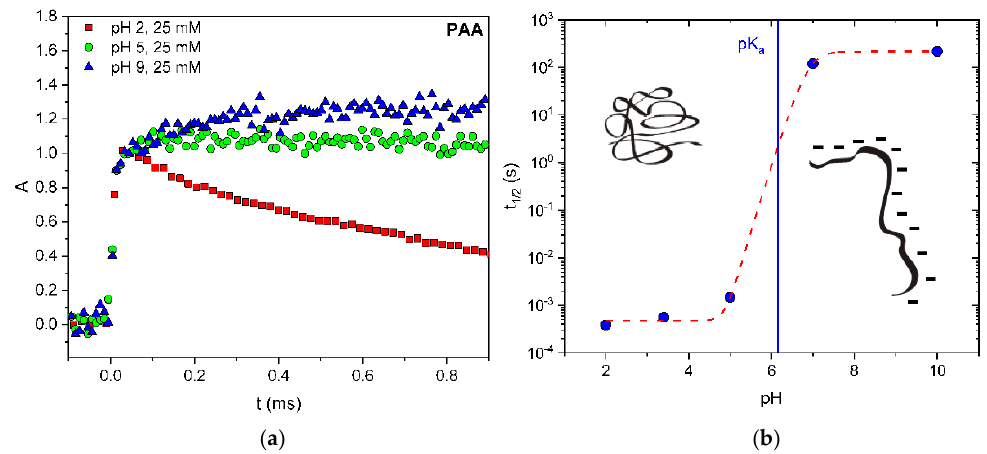
Figure 3. ( a ) Pulse radiolysis of N 2 O-saturated aqueous solutions containing 25 mmol dm − 3 poly(acrylic acid) at various pH. Normalized absorbance at λ = 280 nm as a function of time after pulse. Dose per pulse around 60 Gy. ( b ) Half-life of PAA radicals in N 2 O-saturated aqueous solu- tions containing 10 mmol dm − 3 PAA as a function of pH, and schemes depicting the change in pol- ymer conformation.